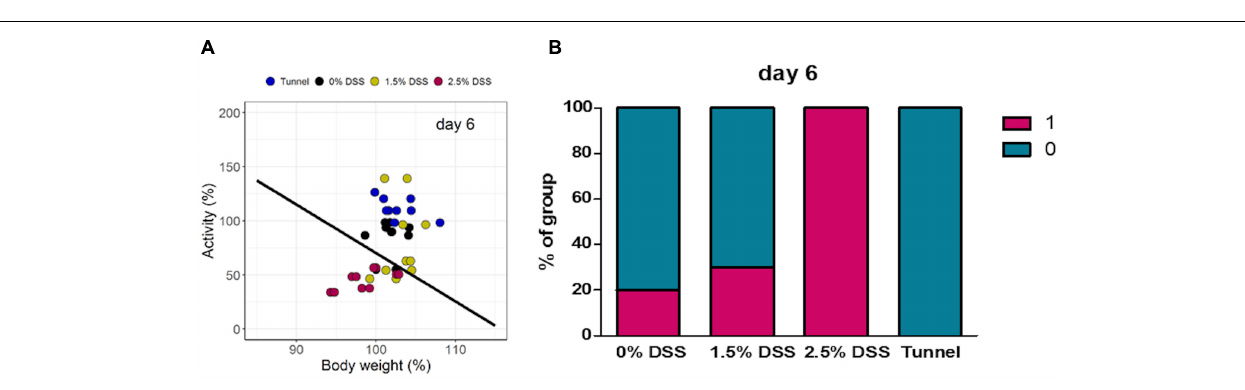
FIGURE 5 | Results of the linear classifier. Data points of all animals based on body weight and activity on day 6. (A) Localization of data points of individual mice and (B) percentage distribution of each group in classes 0 and